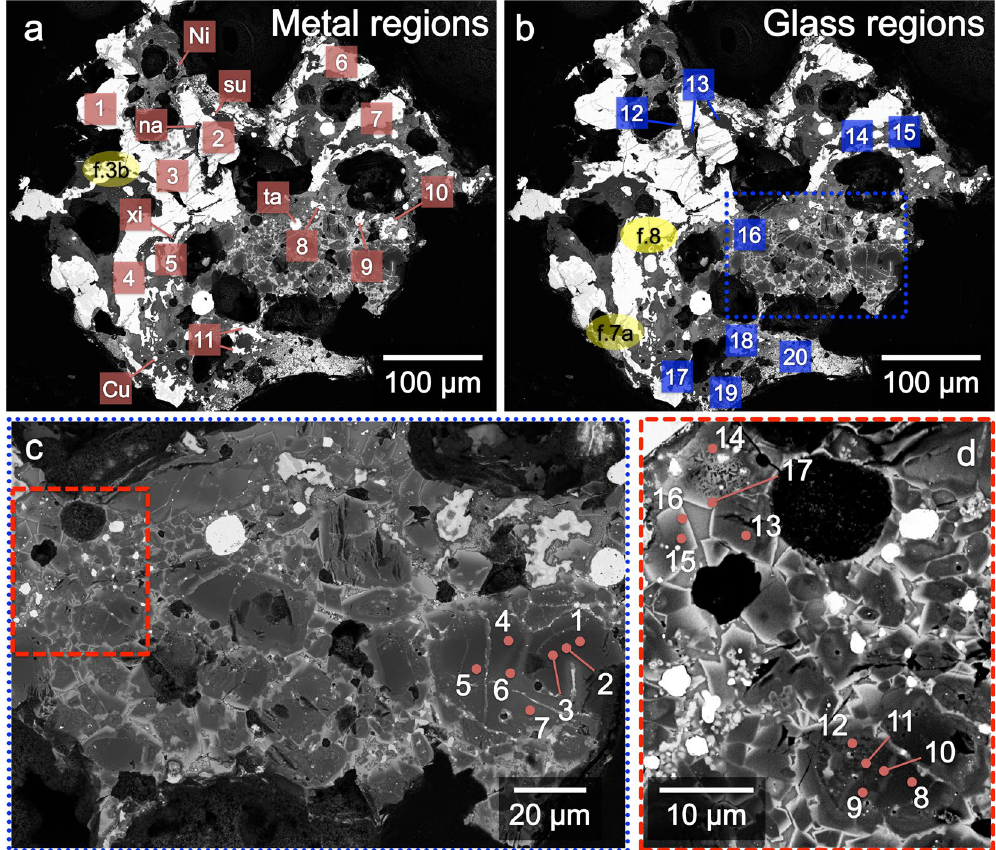
Figure 2. BSE images, marked to show locations of EPMA-WDS and SEM-EDS analyses, with close up views of olivine in ( c ) and ( d ). Red squares in ( a ) indicate metal regions referred to in Table 1. Blue squares in ( b ) indicate glass regions referred to in Table 2b and Fig. 5. Yellow ovals in ( a ) and ( b ) are referred to in Figs 3b, 7a, and 8. ( c ) Close up of area boxed in blue in ( b ). This region contains several olivine crystals. The larger grains are cross-cut by Fe-rich veins that are continuously connected to glass. Analyses of numbered spots are provided in Table 2a. These appear to be relict olivine grains. ( d ) Close up of area boxed in red in ( c ) showing small euhedral to subhedral olivine grains that appear to be a non-relict, second generation of olivine that grew from the matrix melt. Analyses of numbered spots are provided in Table